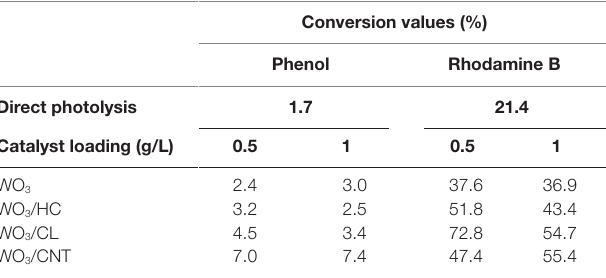
TaBle 2 | conversion values (%) of phenol and rhodamine B achieved after 2 h of irradiation of the studied photocatalysts at two catalyst loadings (ca. 0.5 and 1